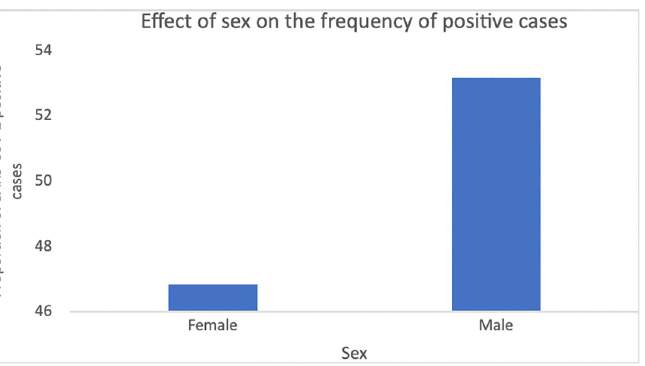
Fig 3. Effects of sex on the frequency of positive cases. A total of 2,880 (53.27%) anti-SARS-CoV-2 Ig-positive individuals were men, while 2,526 (46.72%) were women, the chi-square test revealed no significant association between the proportion of positive cases and gender ( X 2 = 2.890; df = 1; p = 0.090).